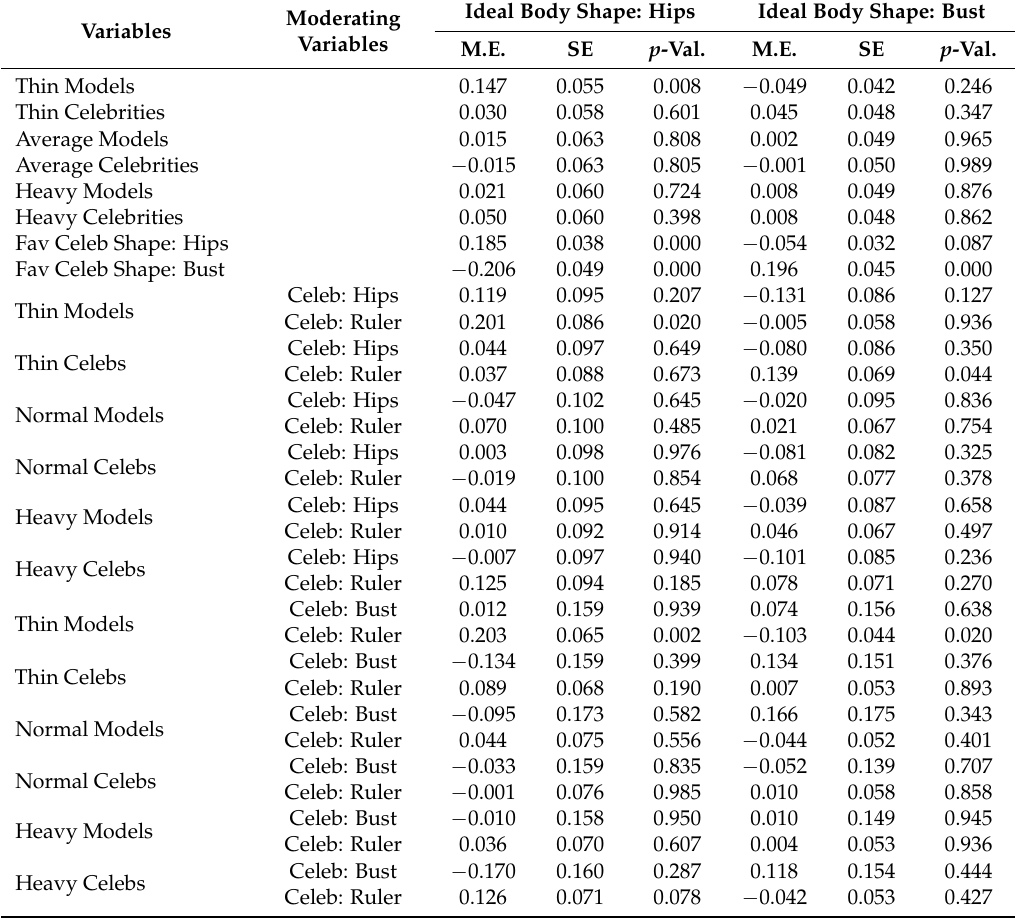
Table 5. Average Marginal Effects on Ideal Body Shape and Celebrity’s Shape